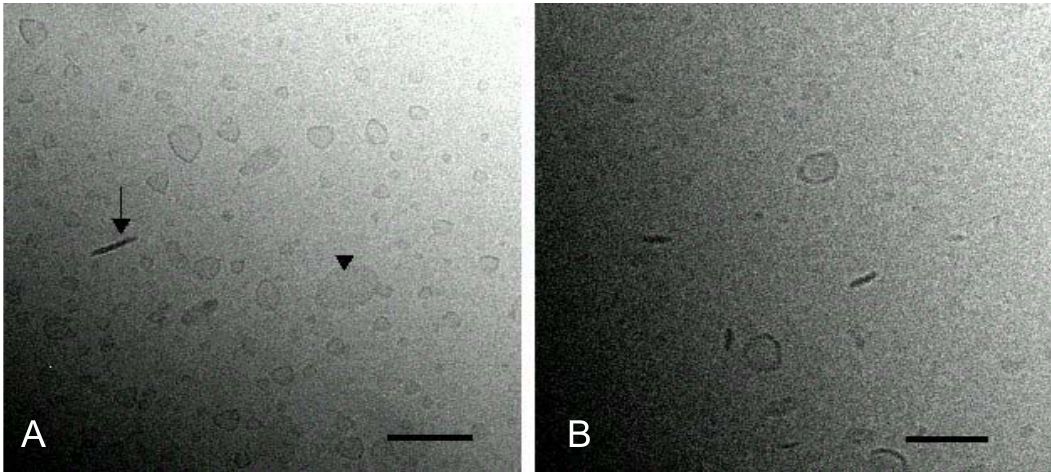
Figure 7. DHAB bilayers containing 0 mol% C The size of the bar represents 100